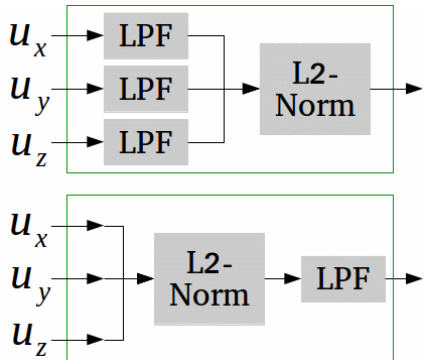
(cid:0) (cid:1) u x ( t ) , u y ( t ) , u z ( t ) , there are two forms of